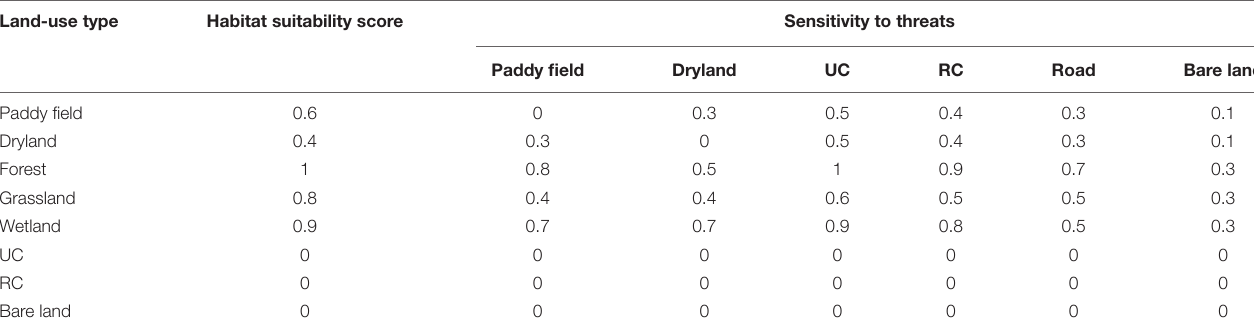
TABLE 3 | Sensitivity coefficient of habitats to threat